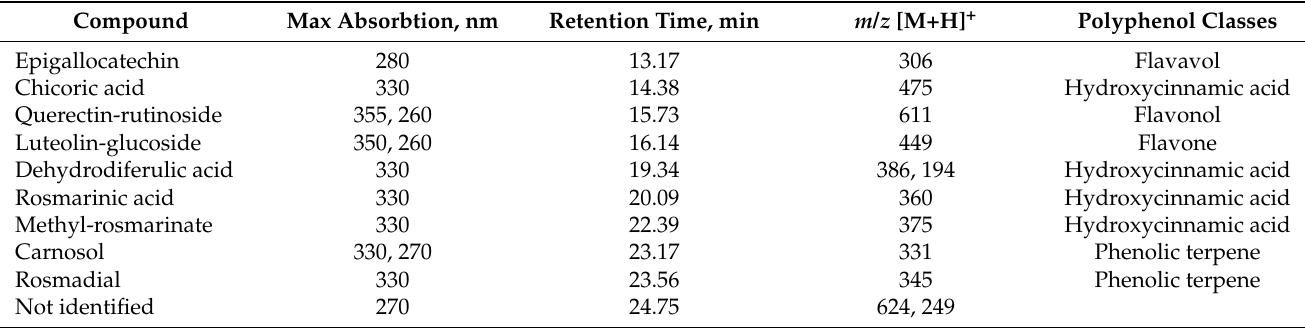
Table 7. Polyphenols used as standards in HPLC analysis of basil